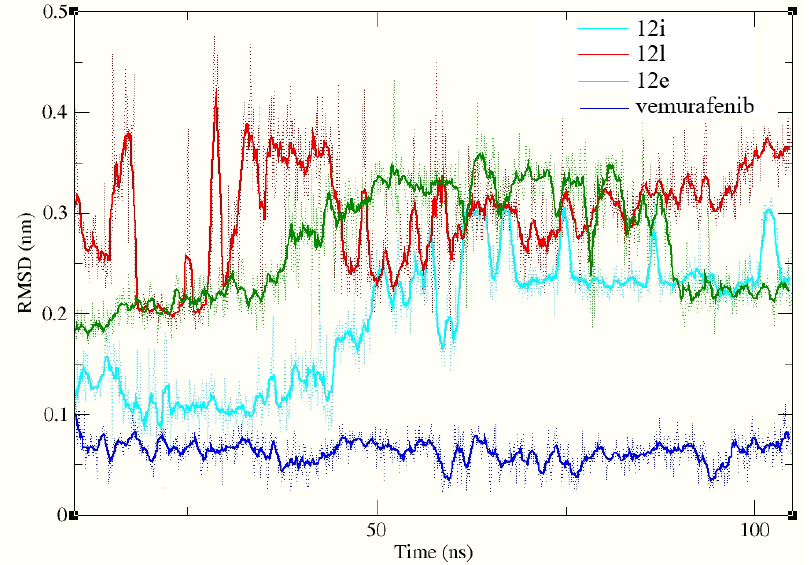
Figure 5. RMSD values of the 12i, 12l and 12e compounds and vemurafenib during 100 ns of conventional molecular dynamics simulations (5–105 ns).